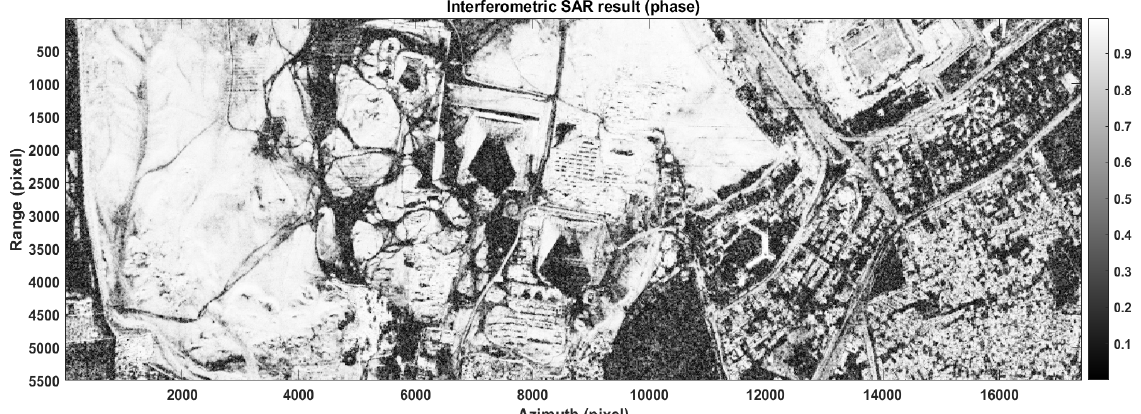
Figure 11. SAR image representing the interferometric repeat-pass coherence of the Giza